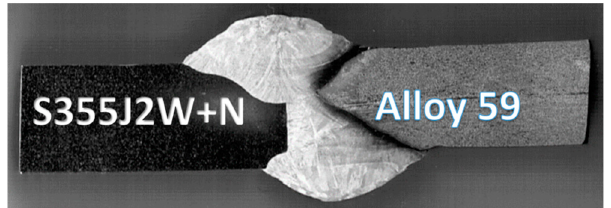
Figure 6. Macroscopic photos of the 8 mm thick joint made of rust-resistant S355J2W+N steel (left side of the weld) and Alloy 59 (right side of the weld).